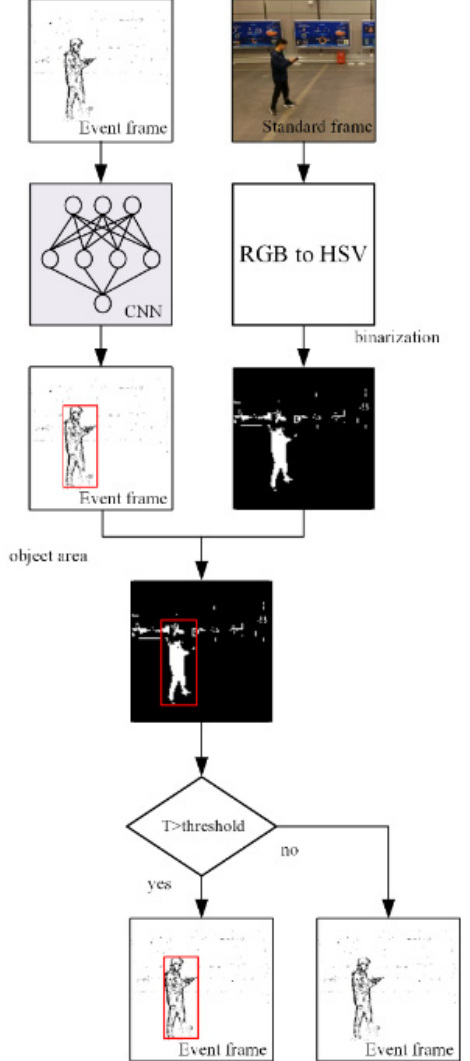
Figure 8. Framework of combined detection based on color.